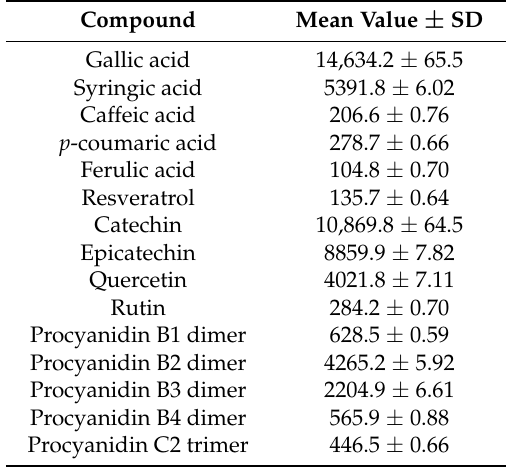
Table 1. High Performance Liquid Chromatography-diode-array detector (HPLC-DAD) analysis of the main polyphenols contained in Taurisolo ® . Values are expressed in µg/g Taurisolo ® ± standard deviation of three repetitions.